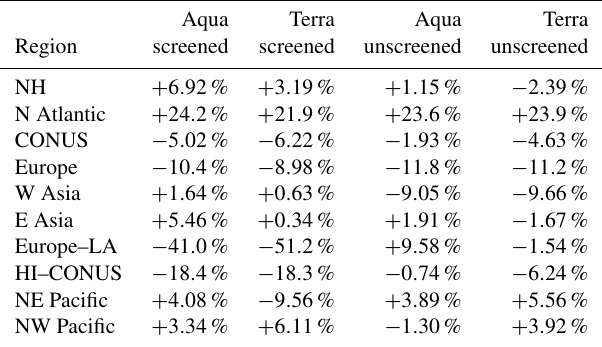
Table 1. Relative change in CC between 2012 and 2006 for the Northern Hemisphere and nine air traffic